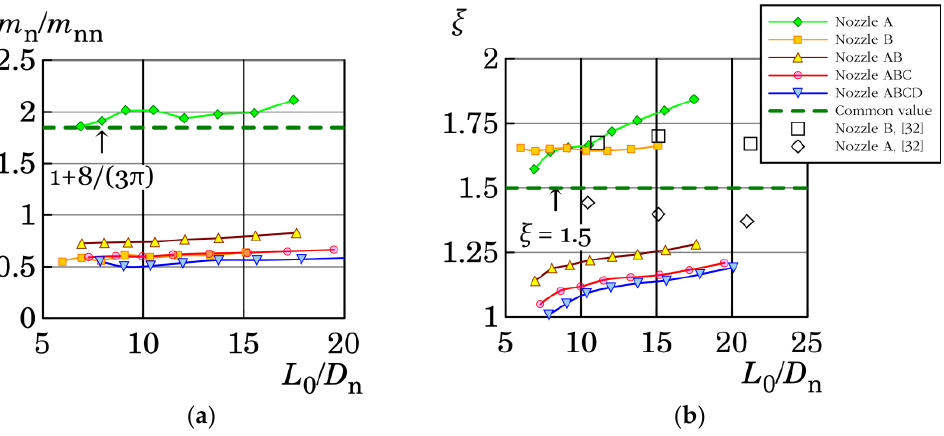
Figure 5. Evaluated parameters for lumped parameter model: ( a ) mass of the moving fluid inside the nozzle related to the fluid mass inside a nozzle, ( b ) pressure loss coefficient at cavity-nozzle-ambiance transition.